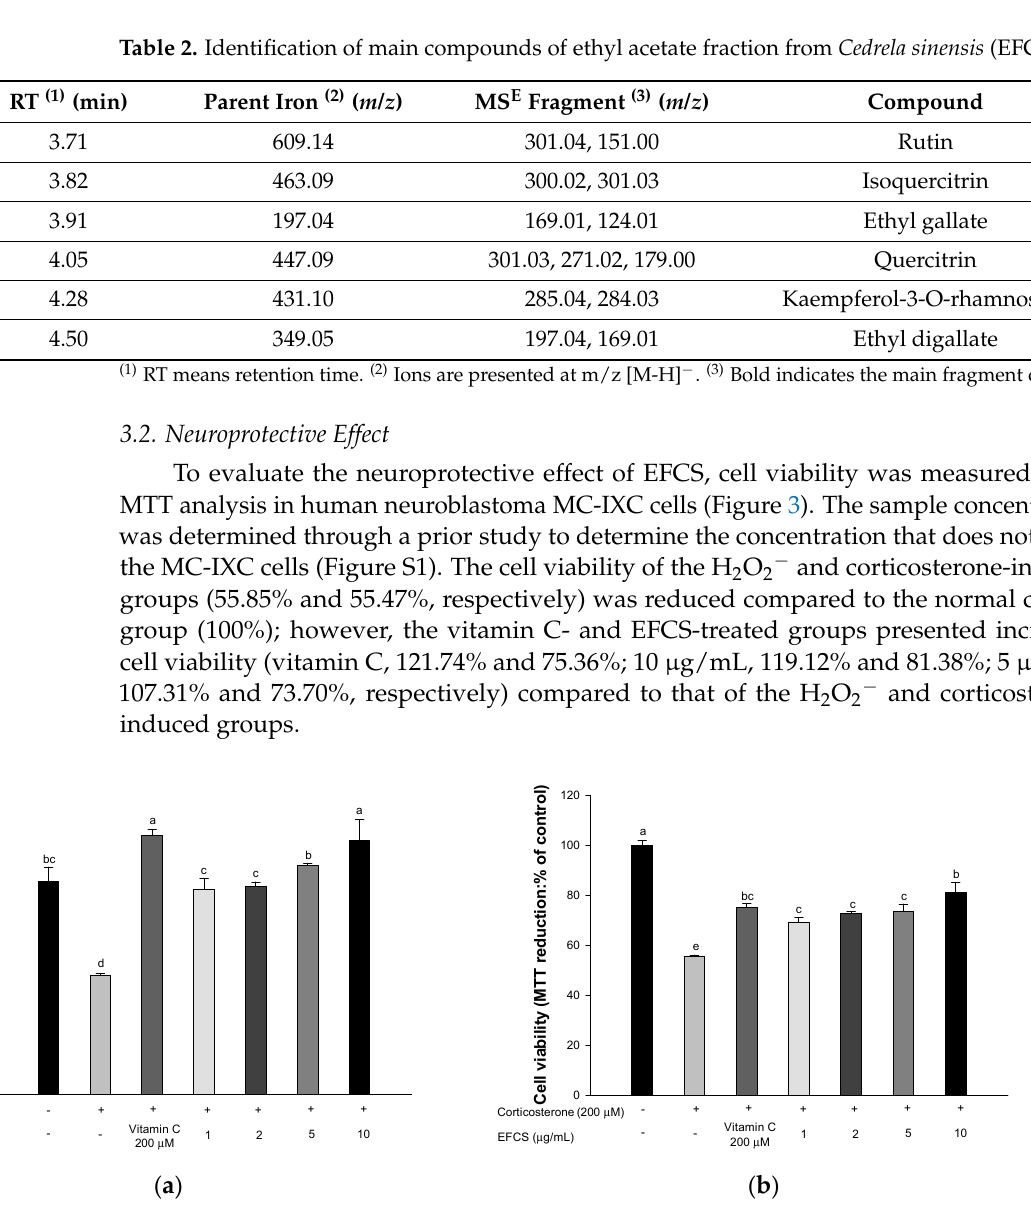
Figure 3. Neuroprotective effects of ethyl acetate fraction from Cedrela sinensis (EFCS) in MC − IXC cells. H 2 O 2 − induced cell viability ( a ) and corticosterone-induced cell viability ( b ). Results shown are mean ± SD ( n = 5). Data are statistically represented at p < 0.05, and different lowercase letters indicate statistical significance. Means with the same letter are not significantly different.